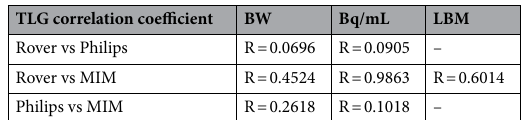
Table 3. Pearson correlation coefficient for TLG value.